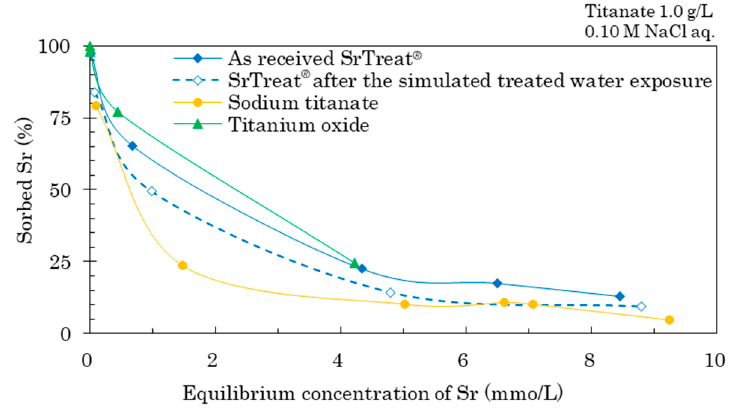
Figure 5. The percentage of sorbed Sr on titanates in this study versus equilibrium Sr concentration at pH = 12.